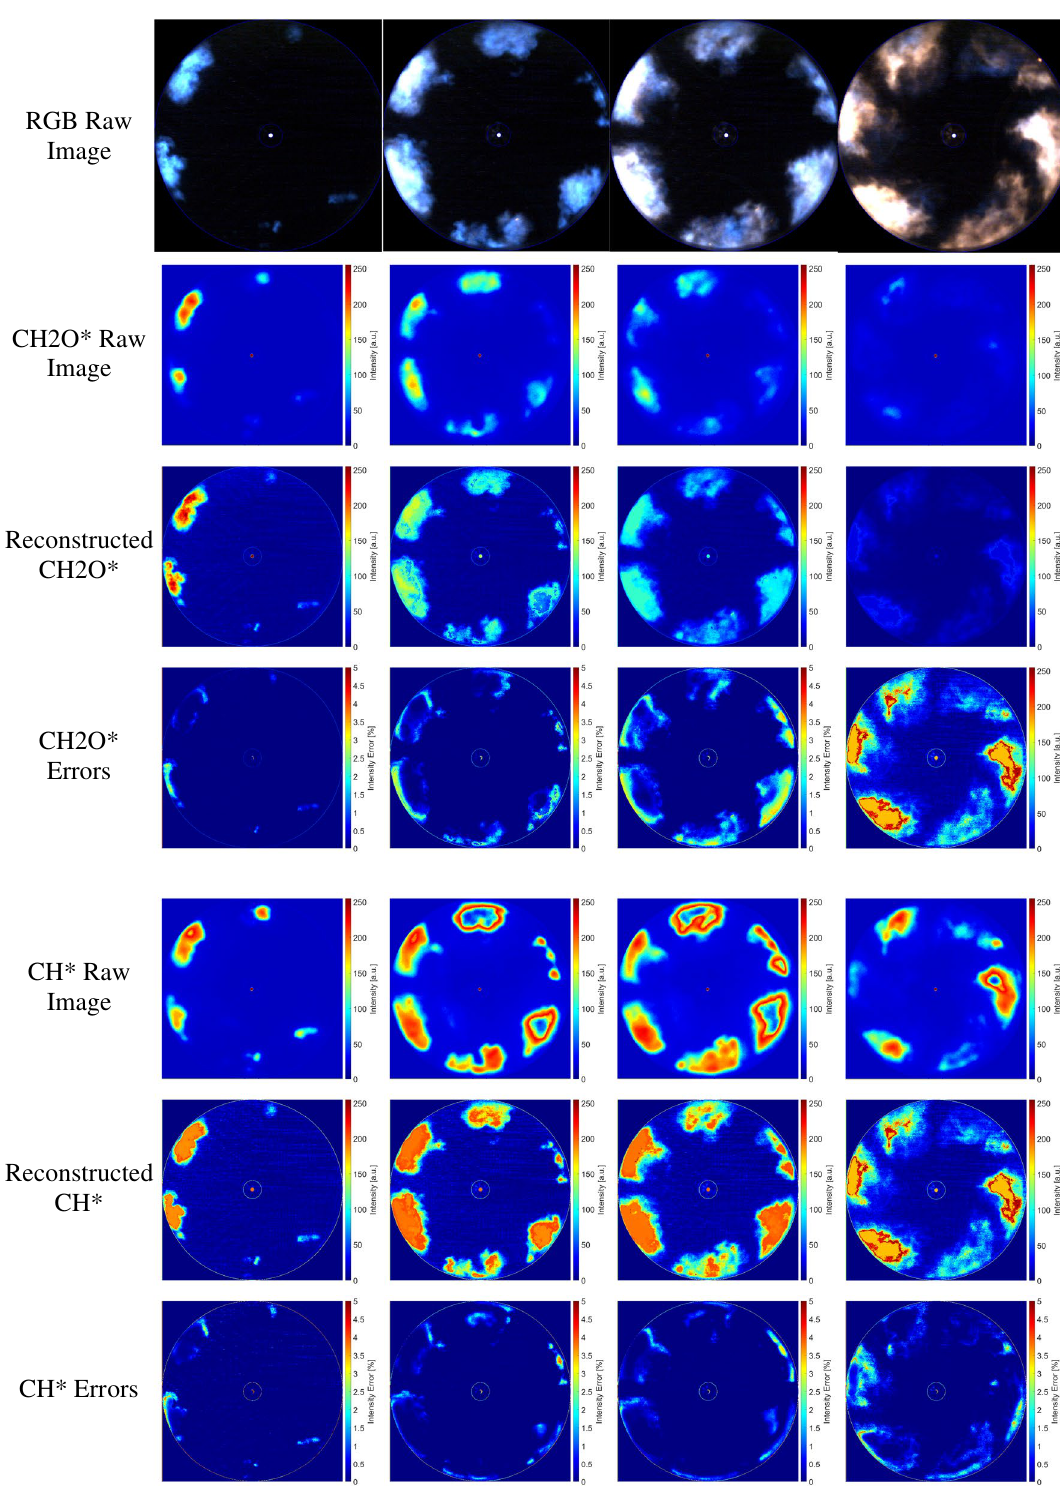
Figure 7. Comparison of reconstructed and raw CH 2 O* and CH* chemiluminescent